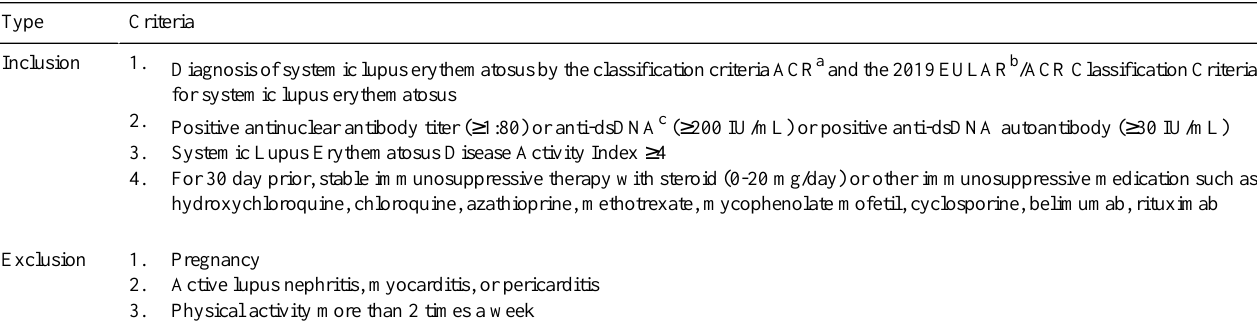
Table 1. Inclusion and exclusion criteria.